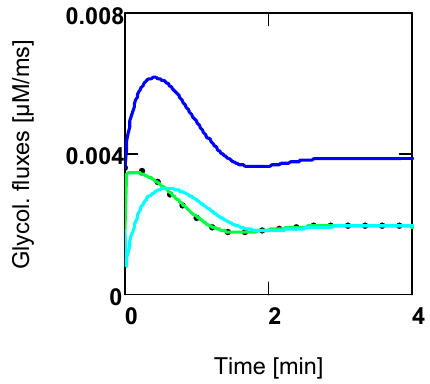
Figure 2. Behaviour of in series fluxes of glycolysis after a twofold increase ( f = 2.0) of max L . (black dots) J GK SIM GLY